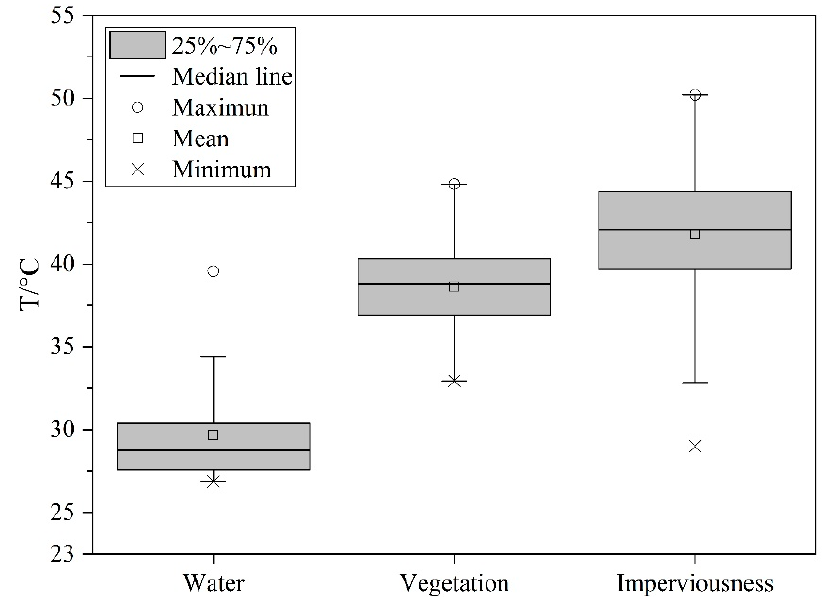
Figure 5. Temperature of different landscape types.